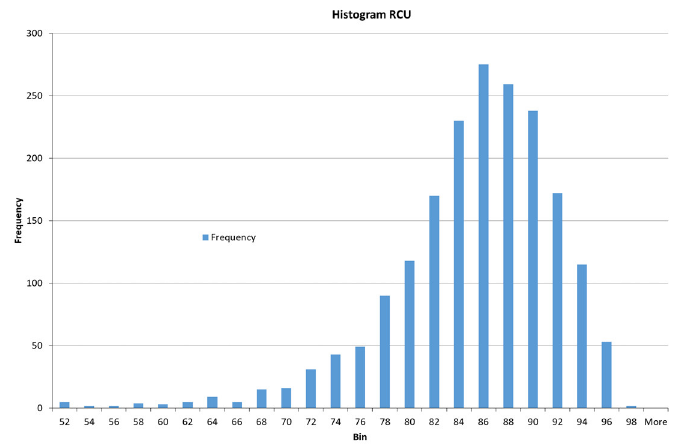
Figure A12. Copper recovery in final concentrate (RCU)—dataset distribution.